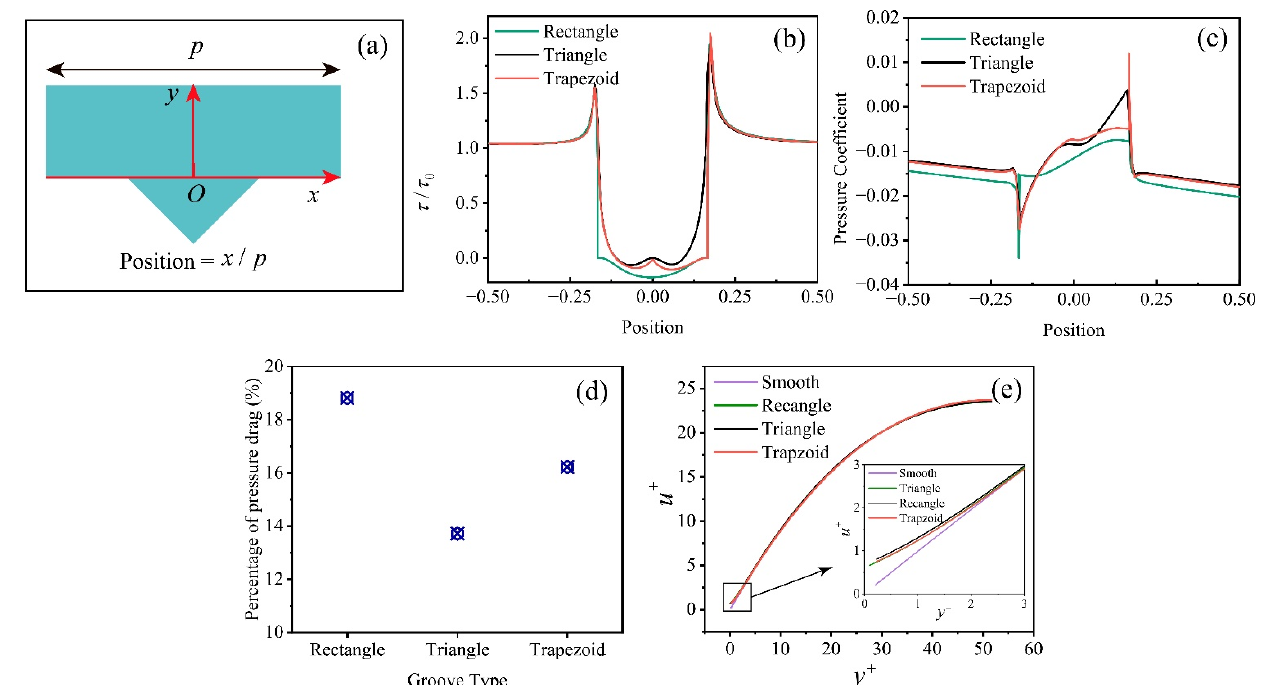
Figure 10. The fluid field profile near the surface: ( a ) the definition of the position using in this figure; ( b ) and ( c ) the dimensionless wall stress on three types of grooves; ( d ) the percentage of pressure drag to the total drag on the surface; ( e ) the velocity distribution near the groove and smooth surface.